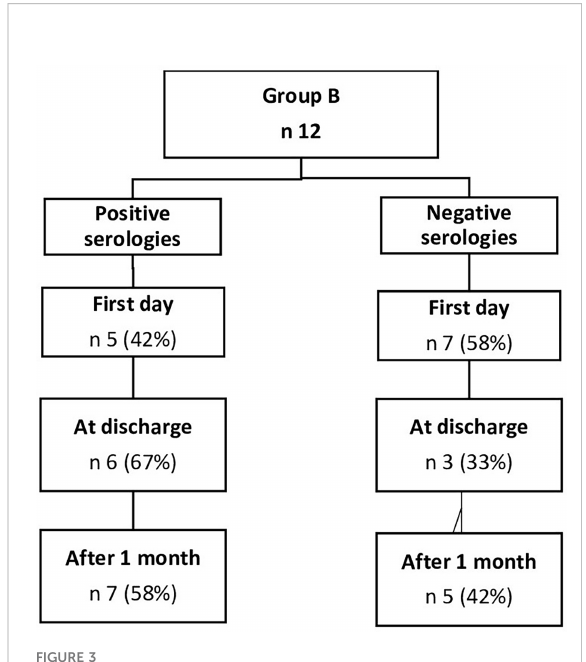
FIGURE 3 Serologies from patients vaccinated before aHSCT (group